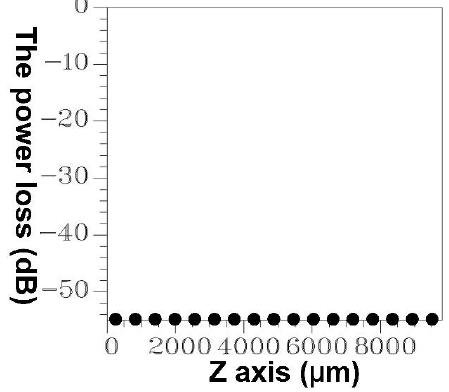
Figure 17. An optical spectra plot of the total counterpropagating HE expresses the core mode and cladding modes transmission power. The red line expresses the core mode and cladding modes reflection power.